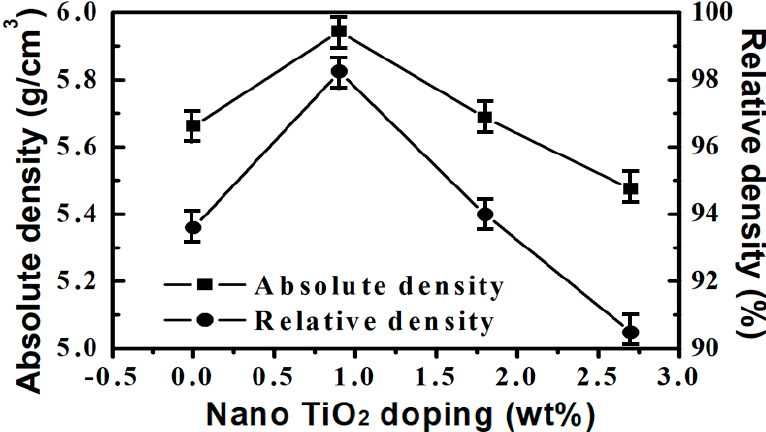
Figure 2. Absolute density and relative density of the microwave-assisted sintered 3Y-TZP samples as function of 0, 0.9, 1.8, and 2.7 wt% nano TiO 2 contents microwave-assisted sintered at 1250 °C.